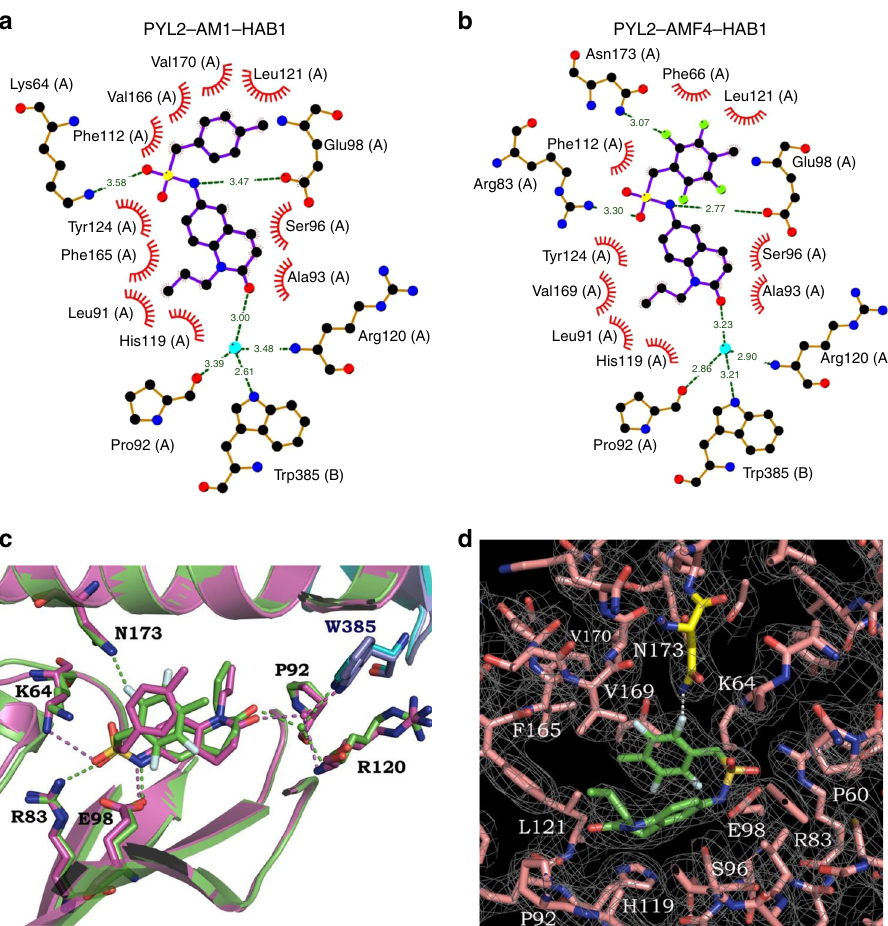
Fig. 3 Structural comparison of AM1 and AMF4 within the PYL2 – HAB1 complex. a , b Two-dimensional structural schematics of interactions between AM1 ( a ) or AMF4 ( b ) and residues in the PYL2 ligand-binding pocket (A) or in HAB1 (B). The schematics show an increase in the number of hydrogen bonds (dashed lines) between the fl uorine atoms (green- fi lled circles) of AMF4 and the nitrogen atoms (blue- fi lled circles) of the Asn173 residue in the PYL2-binding pocket. Red-, yellow-, blue-, and turquoise- fi lled circles represent oxygen atoms, sulfur atoms, nitrogen atoms and water molecules, respectively. The number represents the distance (Å) between two atoms/molecules. The PYL2 – AM1 – HAB1 schematic model is from previously published paper 23 . c Overlay of three-dimensional structural schematics of AM1 (purple) with AMF4 (green) in the PYL2-binding pocket, with hydrogen bonds (dashed lines) and water molecules ( fi lled circles) for AM1 and AMF4 in purple and green colors, respectively. d A 2 F o – 2 F c electron density map of bound AMF4 and its surrounding residues contoured at 1.0 σ . N173 of PYL2 is highlighted in yellow and the white dotted line represents the hydrogen bond between the fl uorine atom of AMF4 and N173 of